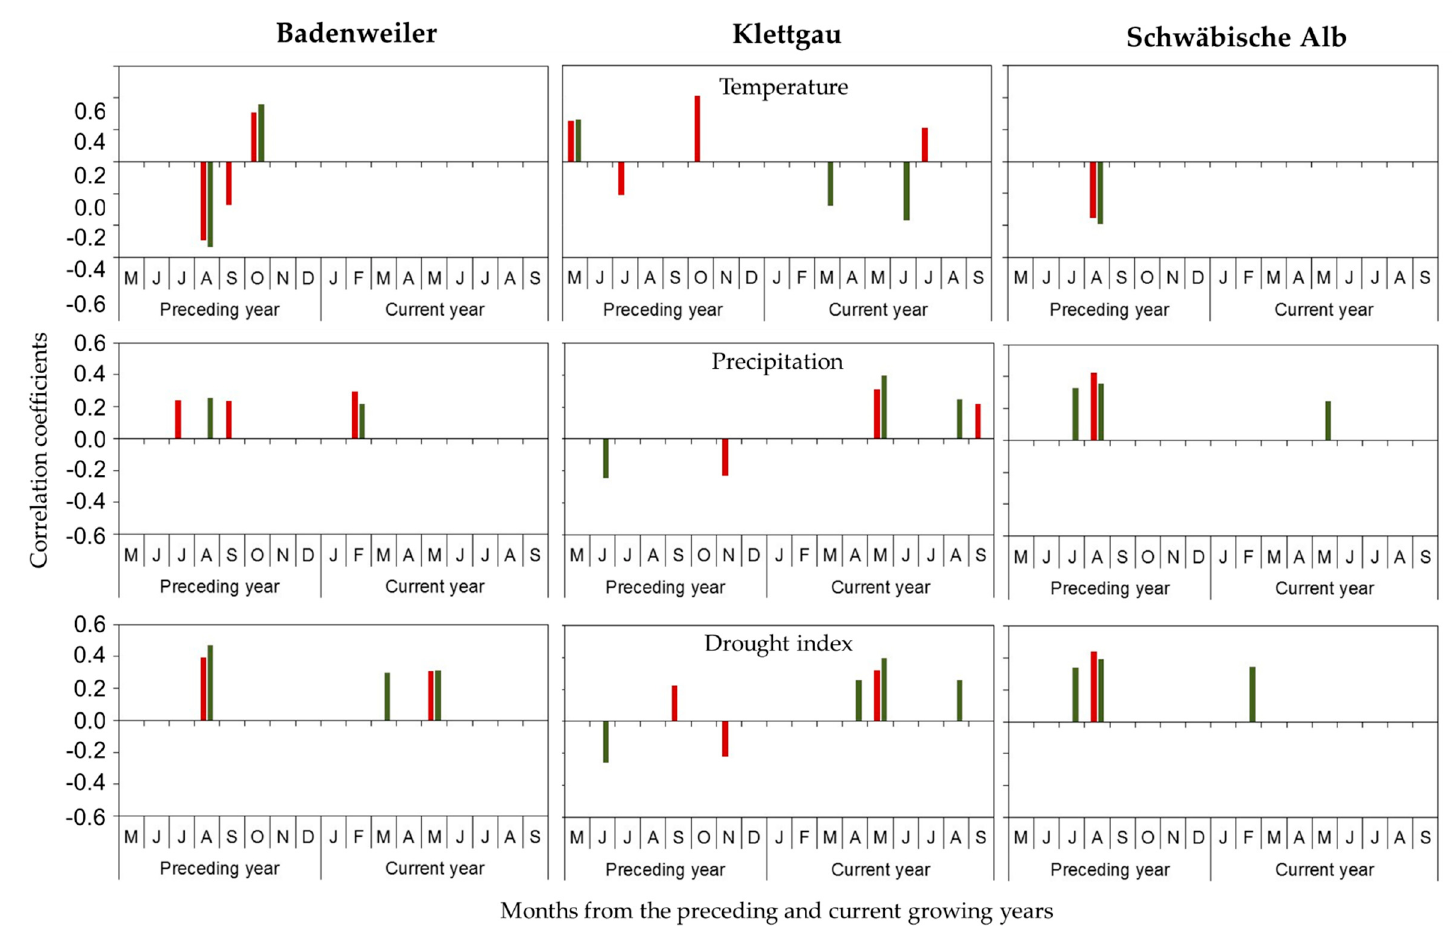
Figure 6. Significant correlations ( p < 0.05) between tree ring width chronology and monthly climatic data for Badenweiler, Klettgau, and Schwäbische Alb. Residual tree ring width index was used as a dependent variable where preceding and current growing months’ temperature, precipitation, and drought index were used as an independent variable. Red bars indicate relations for dry plots and green bars for less-dry plots. Graphs in rows show relations for temperature, precipitation, and drought index from top to bottom; respectively, graphs in columns show relations for different locations from left to right.